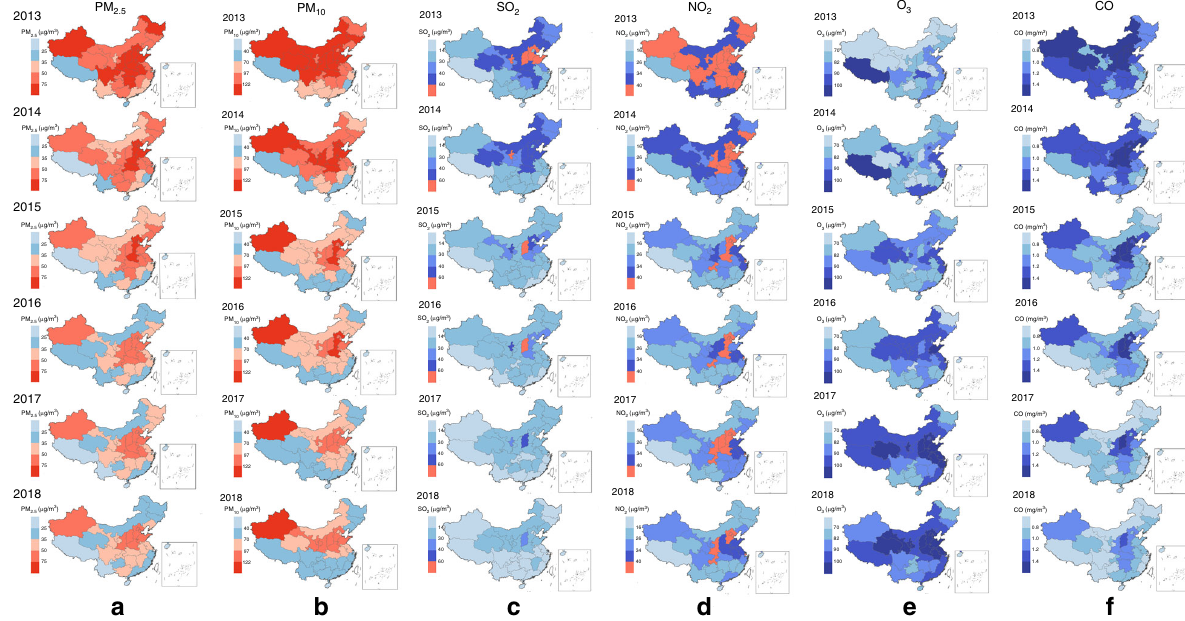
a Fig. 3 Changes of spatiotemporal distribution of six air pollutants in China, 2013 – 2018. a The changes of average annual value of particulate matter of <2.5 μ m (PM 2.5 ) during 2013 – 2018 in 31 provinces of China. b The changes of average annual value of particulate matter of <10 μ m (PM 10 ) during 2013 – 2018 in 31 provinces of China. c The changes of average annual value of sulfur dioxide (SO 2 ) during 2013 – 2018 in 31 provinces of China. d The changes of average annual value of nitrogen dioxide (NO 2 ) during 2013 – 2018 in 31 provinces of China. e The changes of average annual value of ozone (O 3 ) during 2013 – 2018 in 31 provinces of China. f The changes of average annual value of carbon monoxide (CO) during 2013 – 2018 in 31 provinces of China. Choropleth maps of average annual value of air pollutants by region. Red means over China guidelines II (issued 2018); Blue: means below China guidelines II. Depth of color denotes air pollutants concentration. Source data are provided as a Source Data fi le deposited on a publicly available website (https://doi.org/10.6084/m9. fi gshare.12237596.v2).